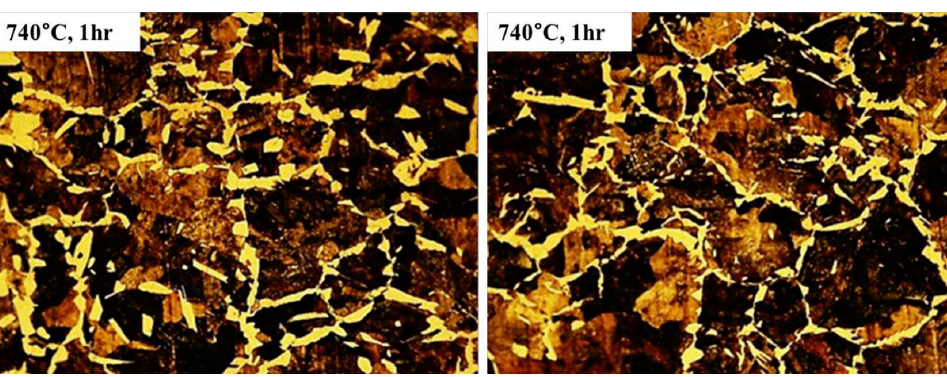
FIG. 4. OPTICAL MICROSCOPY OF SLOW HEATING RATE IN THE BOX FURNACE AT 740°C FOR 1 HOUR